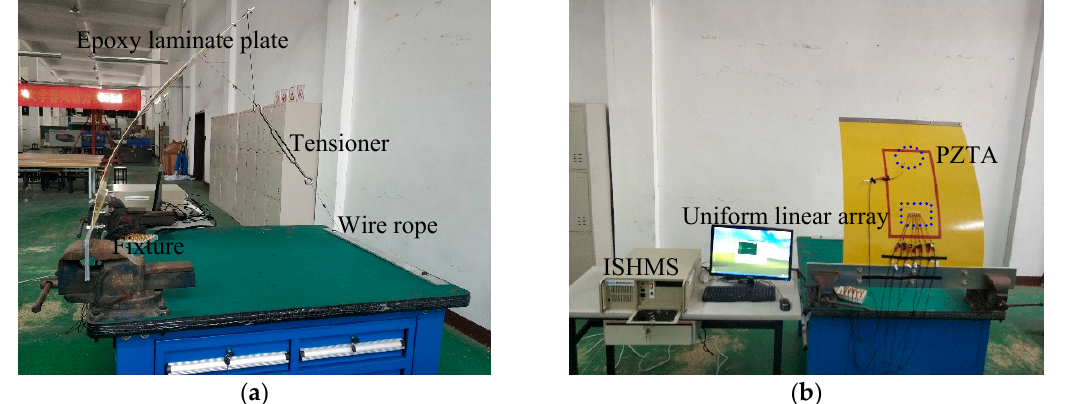
Figure 1. Deformation experiment. ( a ) Bent epoxy laminate plate; ( b ) experiment setup.